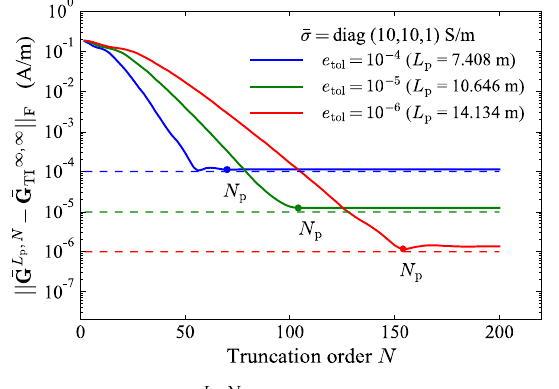
L p , N ¯ Figure 6. Error of p , L N G with increasing truncation order N for three cases of Figure 6. Error of G with increasing truncation order N for three cases of L p when the medium dium is anisotropic. is